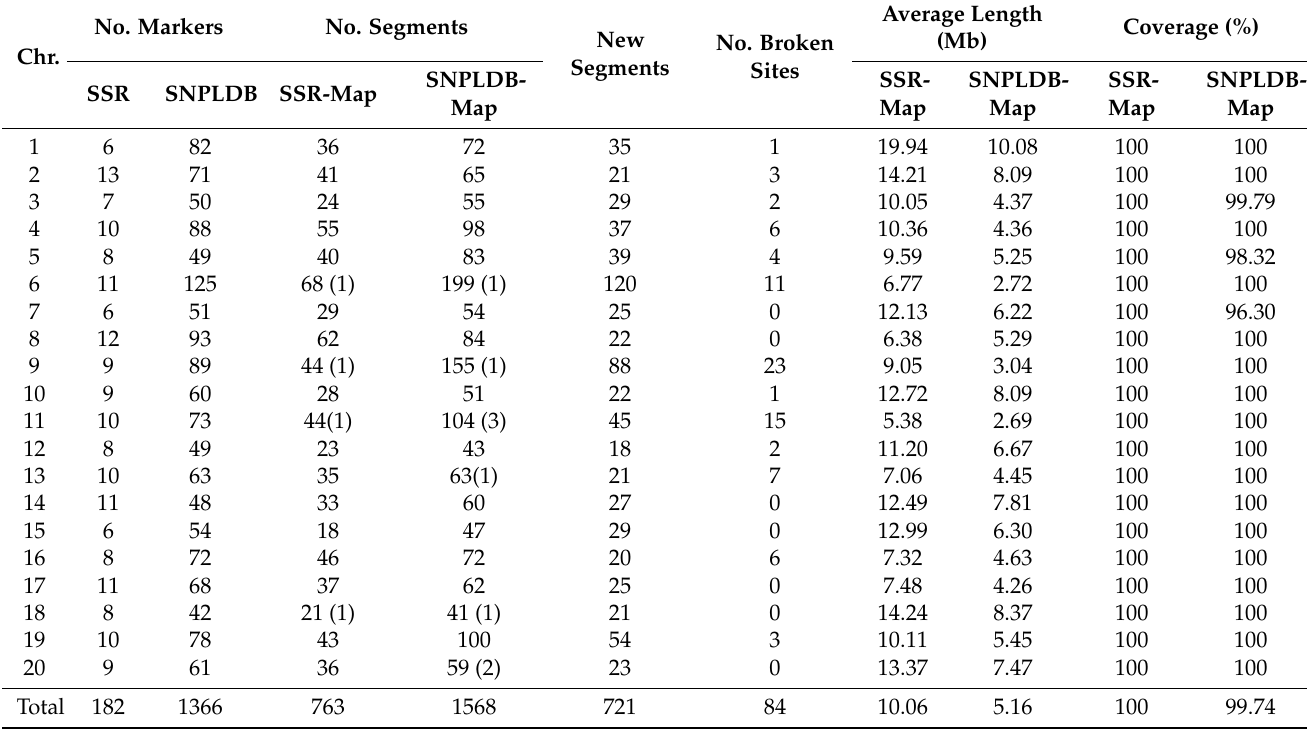
Table 1. SSR and SNPLDB linkage maps of